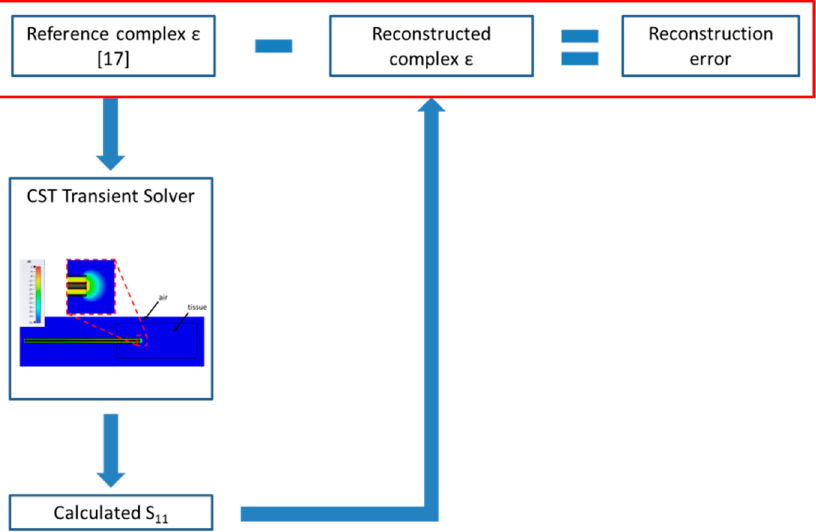
Figure 2. Flow diagram showing reconstruction error calculation. Table 1. Cases considered in the sensitivity analysis.